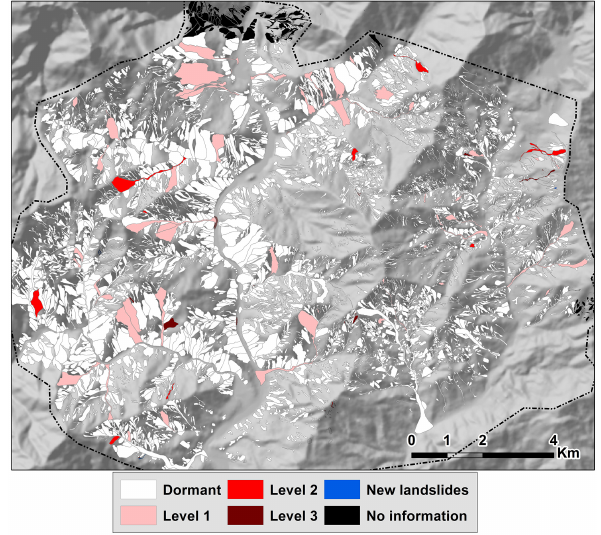
Figure 10. Landslide inventory map based on the image taken in April 2015, reflecting the state of activity after the rainy seasons of 2013 and 2014.